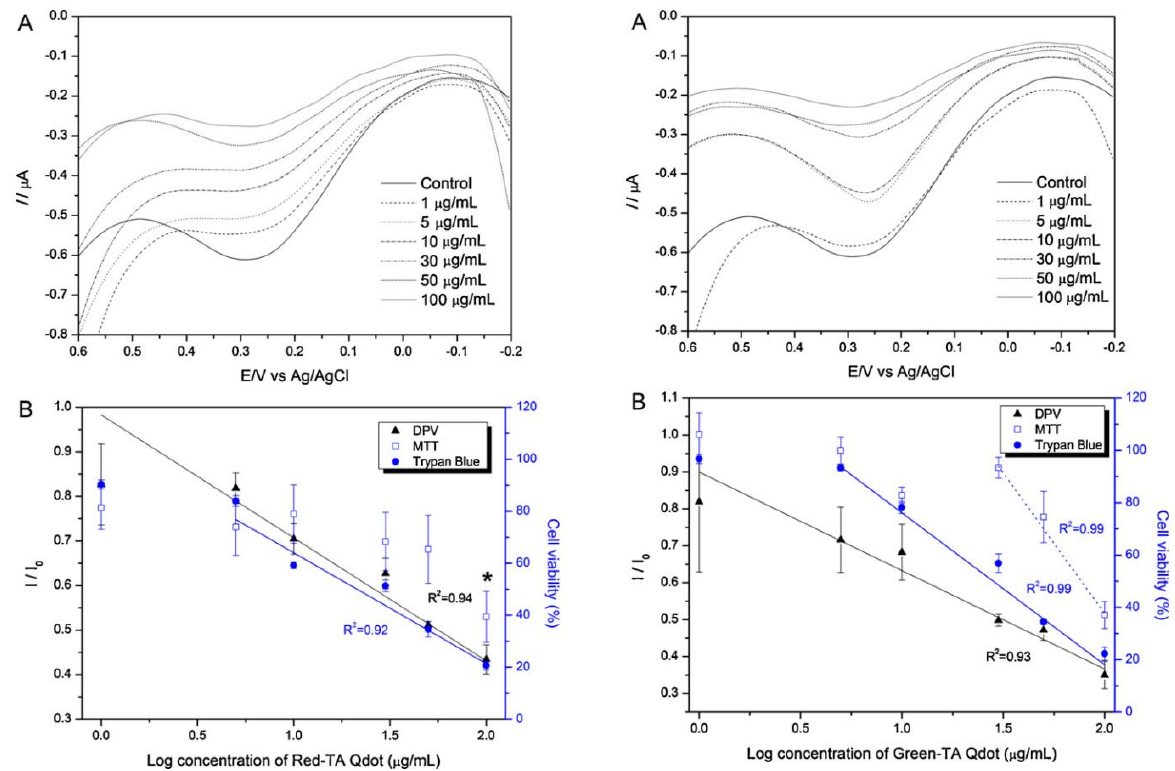
Figure 9. Concentration-dependent effects of Red-TA QDs on SH-SY5Y cells: ( A ) Differential pulse voltammogram of SH-SY5Y cells treated with different concentrations of Red-TA QDs (1, 5, 10, 30, 50, and 100 g/mL); ( B ) Correlations between cell viability and DPV, MTT, and trypan blue assay results corresponding to different concentrations of Red-TA QDs. I 0 means the peak current obtained from cells not treated with Red-TA QDs. Huge decrease of cell viability are marked with an asterisk ( * ). Error bars are the mean ± standard deviation of three different experiments. Reproduced with permission from [29], Copyright 2012,